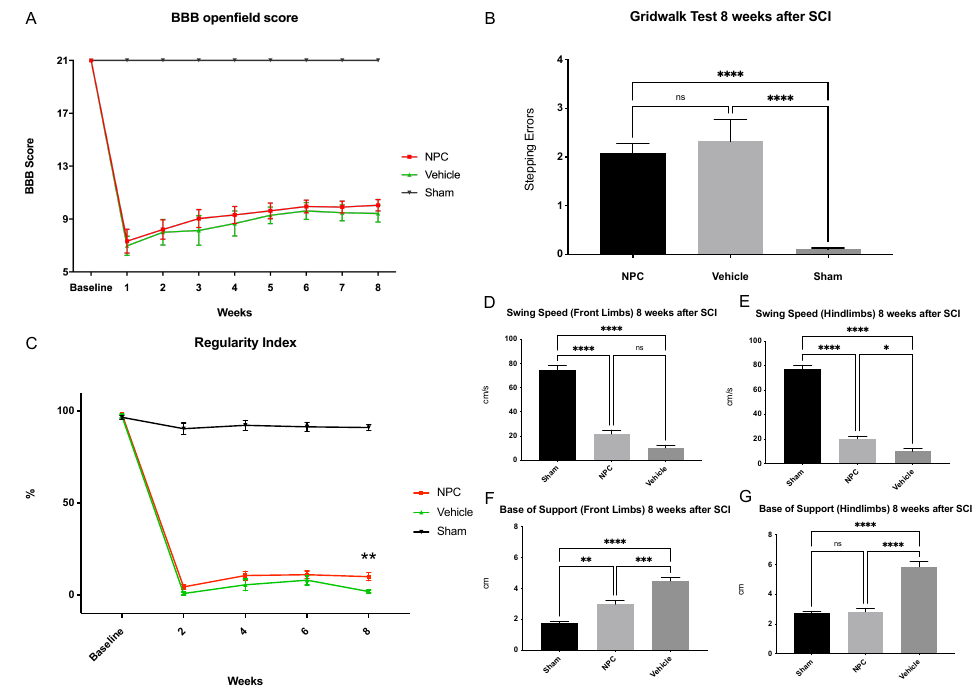
Figure 6. Functional recovery from baseline until eight weeks after severe cervical SCI. ( A ) While Sham animals (group 3; n = 8 animals) received 21 points on the BBB score at every timepoint, no significant difference in the BBB score could be observed between NPC animals (group 1) and Vehicle animals (group 2) throughout the experiment and recovery of injured animals generally remained low ( n = 13 animals in the NPC group and n = 9 animals in the Vehicle group; two-way repeated measures ANOVA with Tukey test for multiple comparisons). ( B ) Similarly, assessment of fine motor control with the Gridwalk test revealed no significant difference between the NPC and the Vehicle animals at the end of the experiment ( n = 13 NPC animals, n = 9 Vehicle animals and n = 8 Sham animals; one-way ANOVA with Tukey-HSD-test; p = 0.7984). ( C ) In contrast, the “Regularity Index” of the more objective CatWalk XT automated quantitative gait analysis as a measurement for coordination was significantly improved in NPC animals compared to Vehicle animals eight weeks after the injury ( n = 13 NPC animals, n = 9 Vehicle animals and n = 8 Sham animals; two-way repeated measures ANOVA with Tukey test for multiple comparisons; p = 0.0051). Furthermore, while indifferent for the front limbs ( D ), the “Swing Speed” of the hindlimbs ( E ) in the CatWalk XT automated quantitative gait analysis was significantly improved in NPC animals compared to Vehicle animals eight weeks after SCI, suggesting less limping after NPC-transplantation ( n = 13 NPC animals, n = 9. Vehicle animals and n = 8 Sham animals; Kruskal–Wallis test followed by Dunn’s multiple comparisons test; p = 0.0959 and p = 0.0158, respectively). Similarly, the “Base of Support” indicating trunk stability and weight-bearing when decreased was significantly lower in NPC animals compared to Vehicle animals at the end of the experiment in both, the front limbs ( F ) and the hindlimbs ( G ); n = 13 NPC animals, n = 9 Vehicle animals and n = 8 Sham; Kruskal–Wallis test followed by Dunn’s multiple comparisons test; p = 0.0006 and p < 0.0001, respectively) (* p < 0.05; ** p < 0.01; *** p < 0.001; **** p < 0.0001 and ns = not